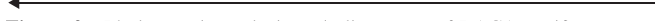
Figure 2 Phylogenetic analysis and alignments of LAG1 motifs. (A) LAG1 motifs of various species were aligned using ClustalW (European Molecular Biology Laboratory – European Bioinformatics Institute Wellcome Trust Genome Campus, Hinxton, Cambridgeshire, UK), alignments were bootstrapped for 1000 datasets each and analyzed for parsimony using Protpars (Joseph Felsenstein, University of Washington, Seattle, WA, USA) from the PHYLIP package (71) with two random shuffles each. A consensus tree was built using Consense (Joseph Felsenstein, University of Washington, Seattle, WA, USA). Saccharomyces cerevisiae LAG1 was used as outgroup. Phylogenetic origin of the CerS2–4 families is poorly resolved. This is also reflected on the sequence level, when aligning the LAG1 motifs. (B) Alignments of LAG1 motifs within the CerS families and their conservation according to ClustalW are shown. Bos taurus and Apis mellifera variants that differ from the LAG1 motif consensus are shown in the first panel, compared to the consensus. Insect CerS are grouped, because they are most similar to one another and C. elegans CerS are also grouped, because they deviate in detail from other CerS families. Conserved amino acids that are specific for one or more CerS families are highlighted. Specific amino acids in CerS1 are highlighted in green, amino acids conserved in CerS5, 6, and a subset in insect CerS are shown in brown. Insect specific amino acids are shown in